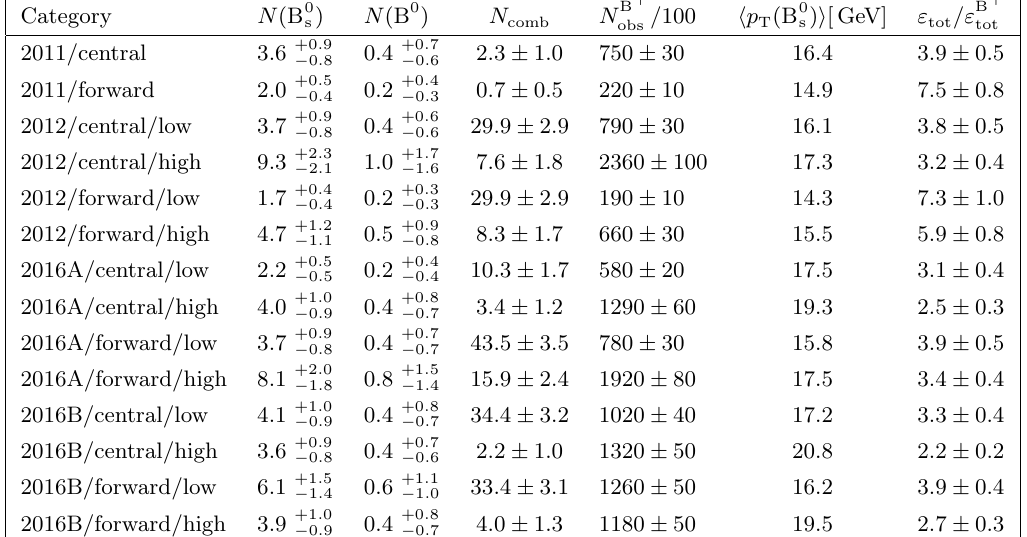
Table 3 . Summary of the (cid:12)tted yields for B 0